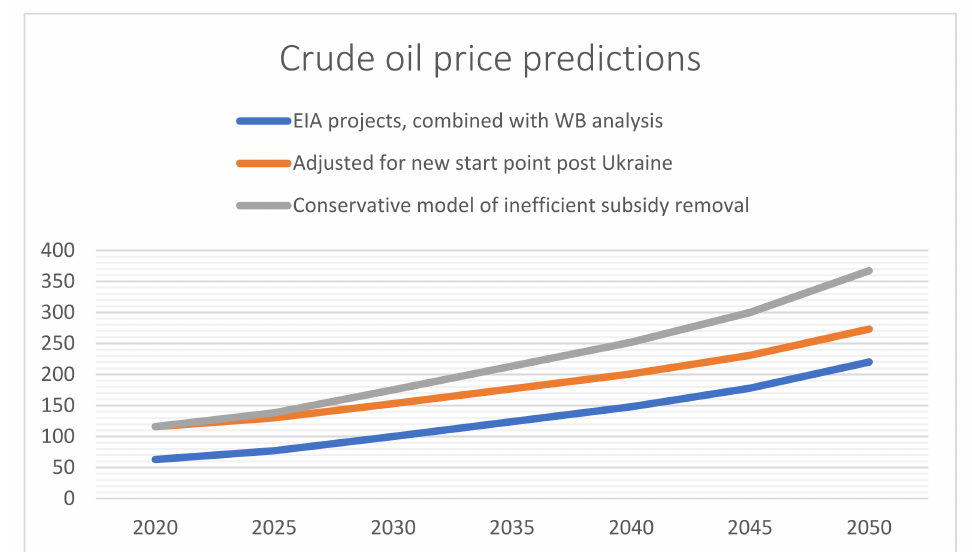
Figure 2. Authors own based on EIA long term brent oil price projection accessed through